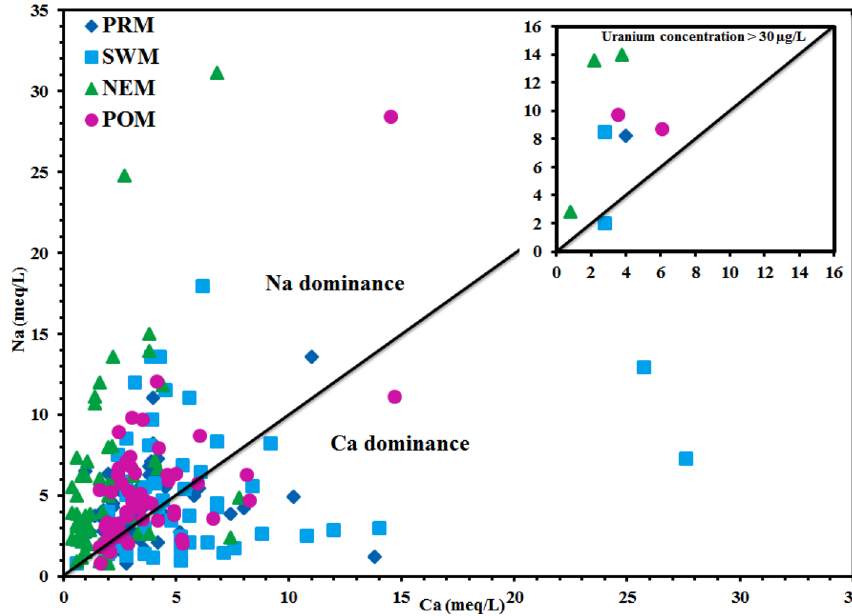
Fig. 9 Na vs. Ca scatter diagram shows that Na/Ca ion exchange increases the concentration of Na in